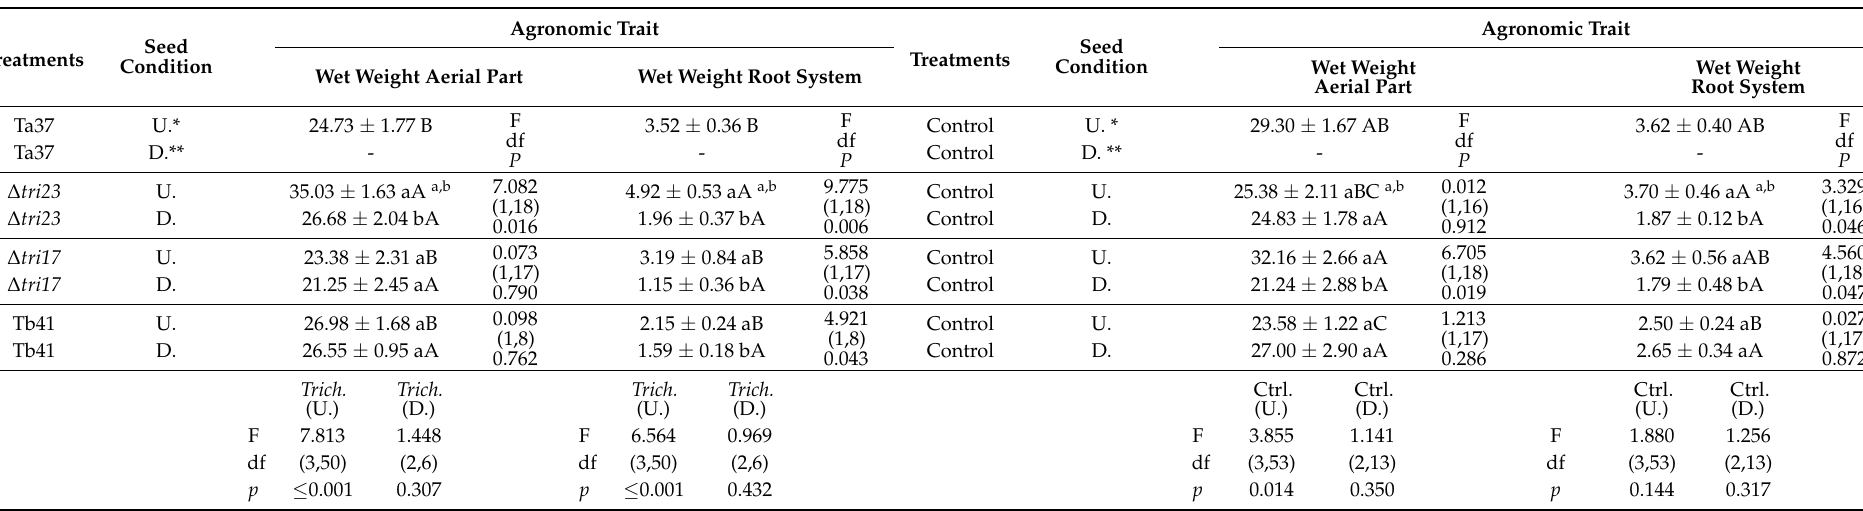
Table 3. Comparison of agronomic traits (grams; mean ± SE) of P. vulgaris plants grown for 45 days from damaged and undamaged beans sprayed with Trichoderma strains and their